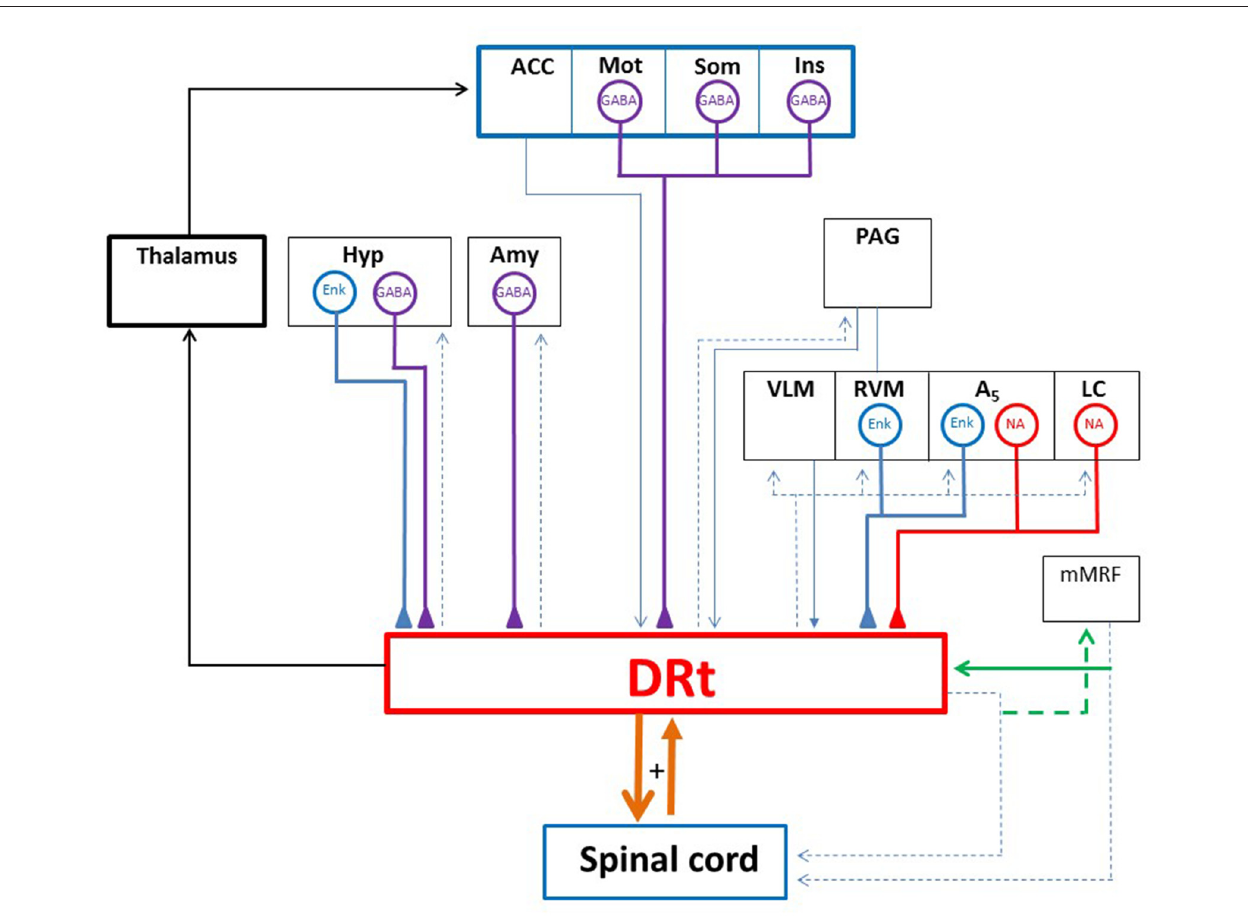
FIGURE 2 | Diagram depicting the DRt connections with the spinal cord and several brain areas. The DRt is involved in a feedback reciprocal loop with the spinal cord ( thick orange lines ) which is involved in pain facilitation. Through its projections to the lateral ventromedial thalamus the DRt participates in a reticulo-thalamo-cortical ascending nociceptive pathway ( thick black lines ). The DRt receives afferent inputs from: (i) higher centers namely the anterior cingulate cortex (ACC), the motor (Mot), somatosensory (Som) and insular (Ins) cortices, the hypothalamus (Hyp) and the amygdala (Amy); and (ii) several brainstem areas namely the periaqueductal gray (PAG), the locus coeruleus (LC), the A 5 noradrenergic cell group along with the two components of the medullary triad (RVM and VLM). The DRt is a major relay for descending pain facilitatory inputs from the ACC, the Hyp and the noradrenergic LC and A 5 areas. The neurochemical characterization of DRt afferents showed that afferents originated in the Mot, Som and Ins cortices as well as the Hyp and the Amy are GABAergic (GABA; thick purple lines ). Hyp afferents and brainstem afferents located at the RVM and the A 5 area are enkephalinergic (ENK; thick blue lines ). The LC and the A 5 noradrenergic cell group constitute the main source of noradrenaline (NA; thick red lines ) released at the DRt. A peculiar reciprocal network is established between the DRt and the medial medullary RF (mMRF) through collaterals ( green lines ) of spinally descending axons. Such an arrangement was described in the cat and is thought to be involved in noxious sensing and nocifensive behavior. Blue thin lines represent neurochemically uncharacterized DRt afferents and dashed lines represent DRt or mMRF